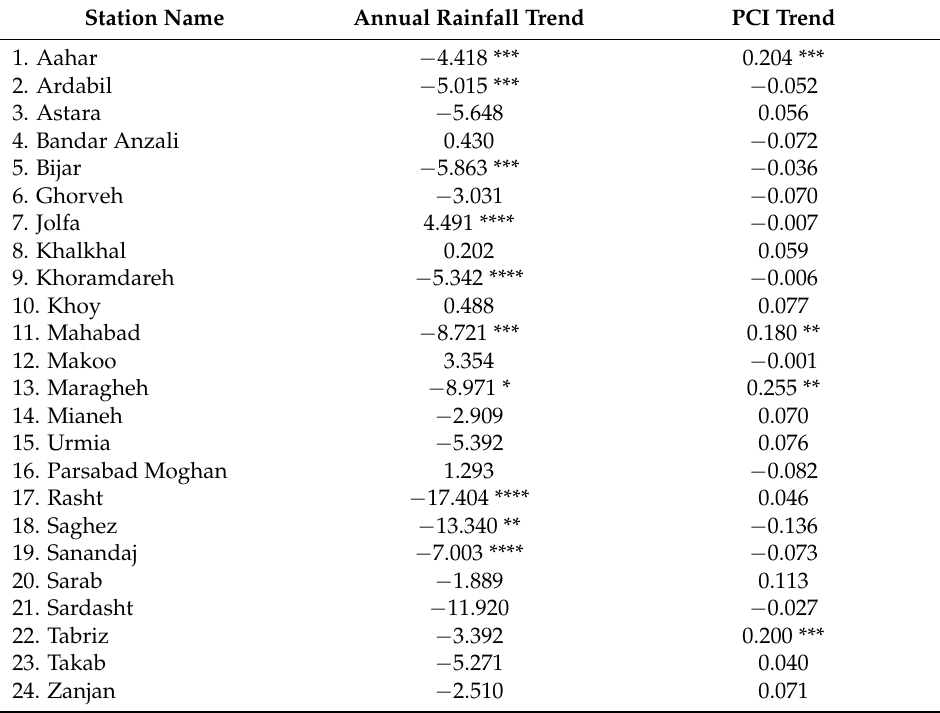
Table 2. Trend of annual rainfall and PCI in 24 stations distributed across northwestern Iran between 1991 and